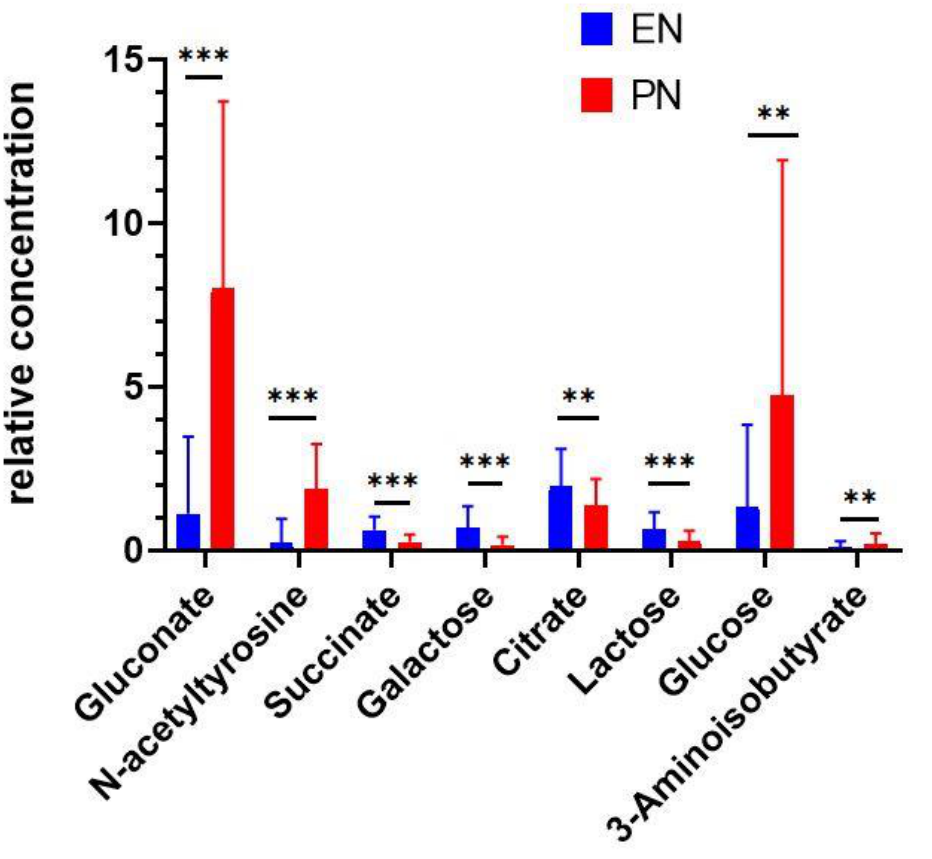
Figure 4. Univariate analyses of relevant metabolites producing significant differences between NT groups identified according to the S-line plot. EN = enteral nutrition; PN = parenteral nutrition. ** p < 0.01, *** p < 0.001.